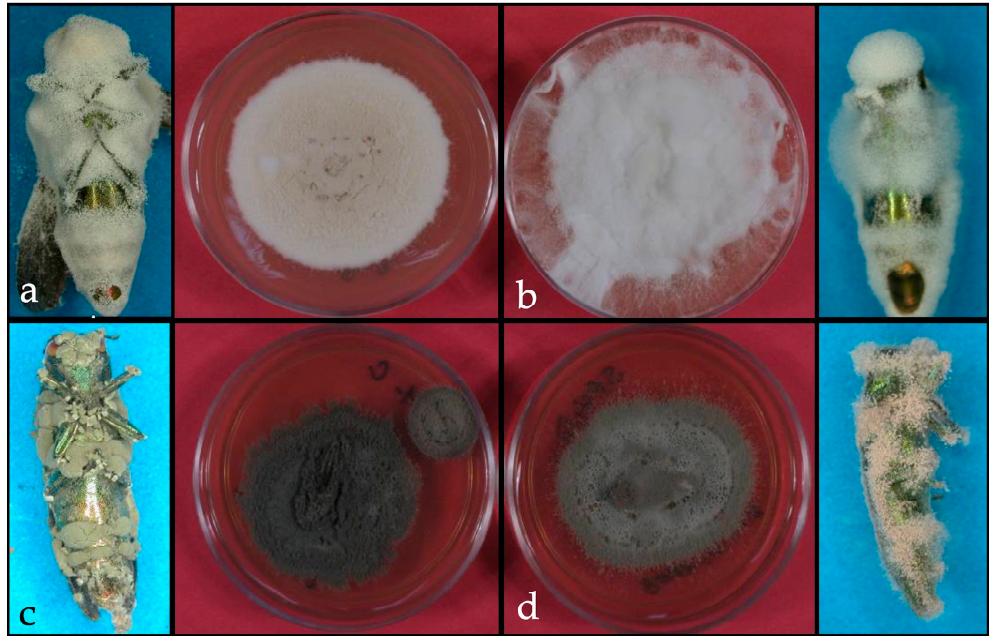
Figure 4. Entomopathogenic fungi on Agrilus planipennis. ( a ). Infected adult and a culture of Beauveria sp., ( b ). Infected adult and a culture of Lecanicillium sp., ( c ). Infected adult and a culture of Metarhizium sp., and ( d ). Infected adult and culture of Paecilomyces sp.